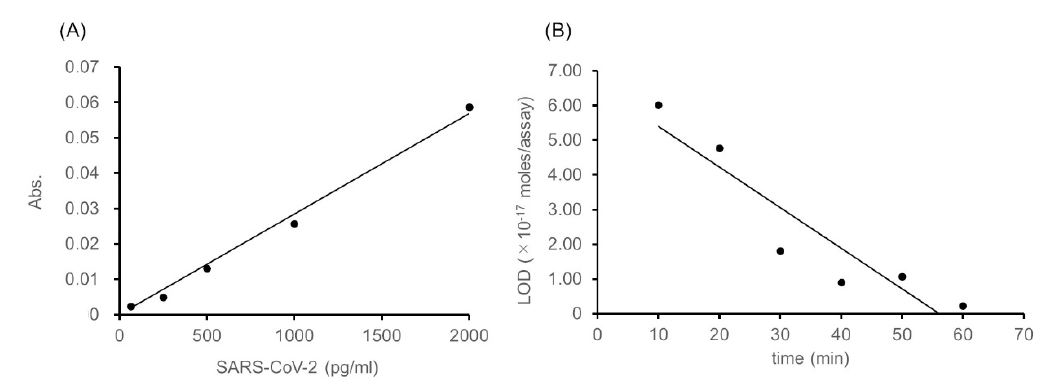
Figure 3. Linear calibration curve obtained from the absorbance at 10 min of thio-NAD cycling and the relation between the period of thio-NAD cycling and the LOD for SARS-CoV-2 spikes. ( A ) Cycling reaction time of 10 min. This linear calibration curve is expressed as y = 3.0 × 10 − 5 x , R 2 = 1.00 in the range of 63–2000 pg/mL. ( B ) The relation between the period of thio-NAD cycling and the LOD for SARS-CoV-2 spikes. This relation is expressed as y = − 1.0 × 10 − 18 x + 7.0 × 10 − 17 , R 2 = 0.86 in the range of 10–60 min of thio-NAD cycling.